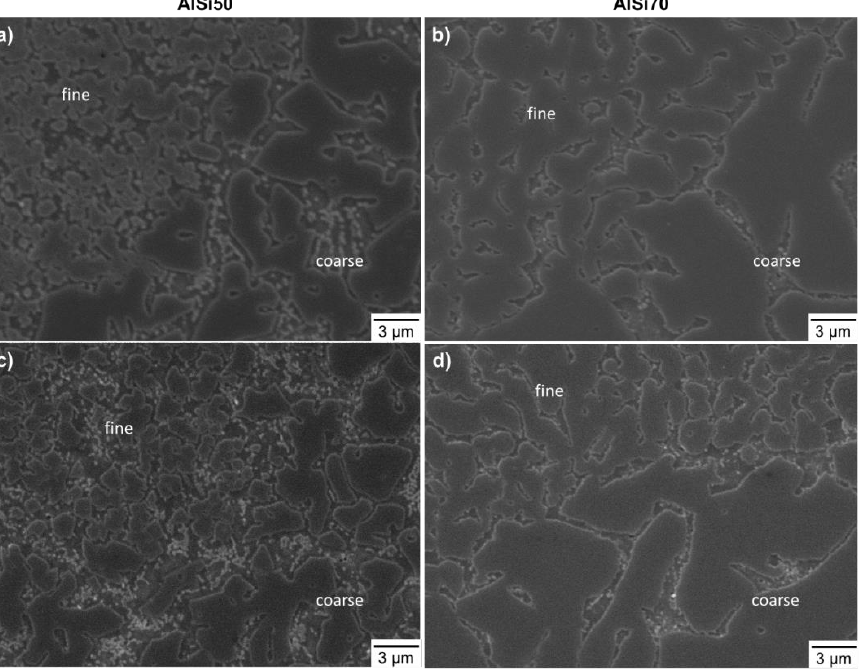
Figure 4. SEM micrographs of the microstructure of: ( a ) AlSi50 p.; ( c ) AlSi50 Al + Si; ( b ) AlSi70 p. + Si and ( d ) AlSi70 Al + Si, recorded in the transition of the fine and coarse area. All samples were built with 1400 mm/s.